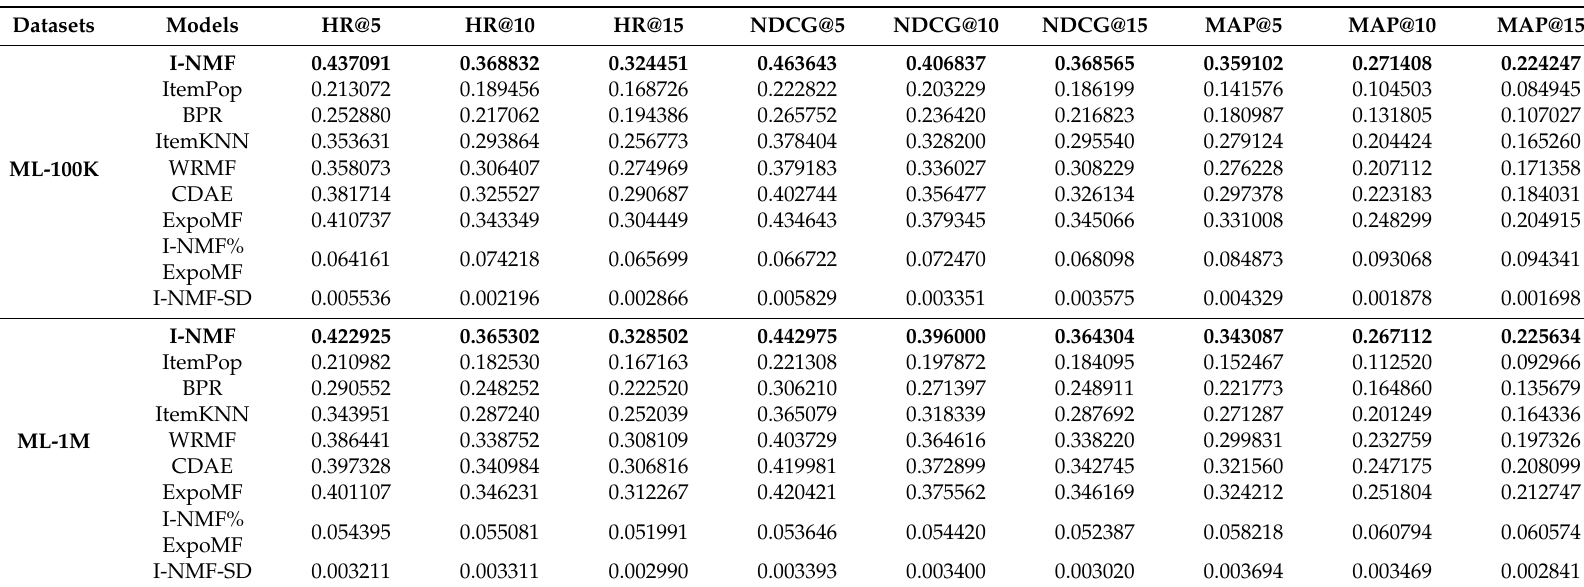
Table 5. Performance comparison of I-NMF and advanced recommendation algorithms based on HR@N, NDCG@N, and MAP@N. (N = 5, 10,